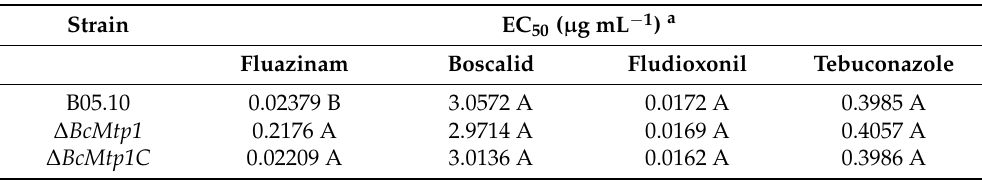
Table 1. Sensitivity of the wild-type progenitor B05.10 and the BcMtp1 deletion mutants ∆ BcMtp1 and the complemented strain ∆ BcMtp1C to different fungicides.